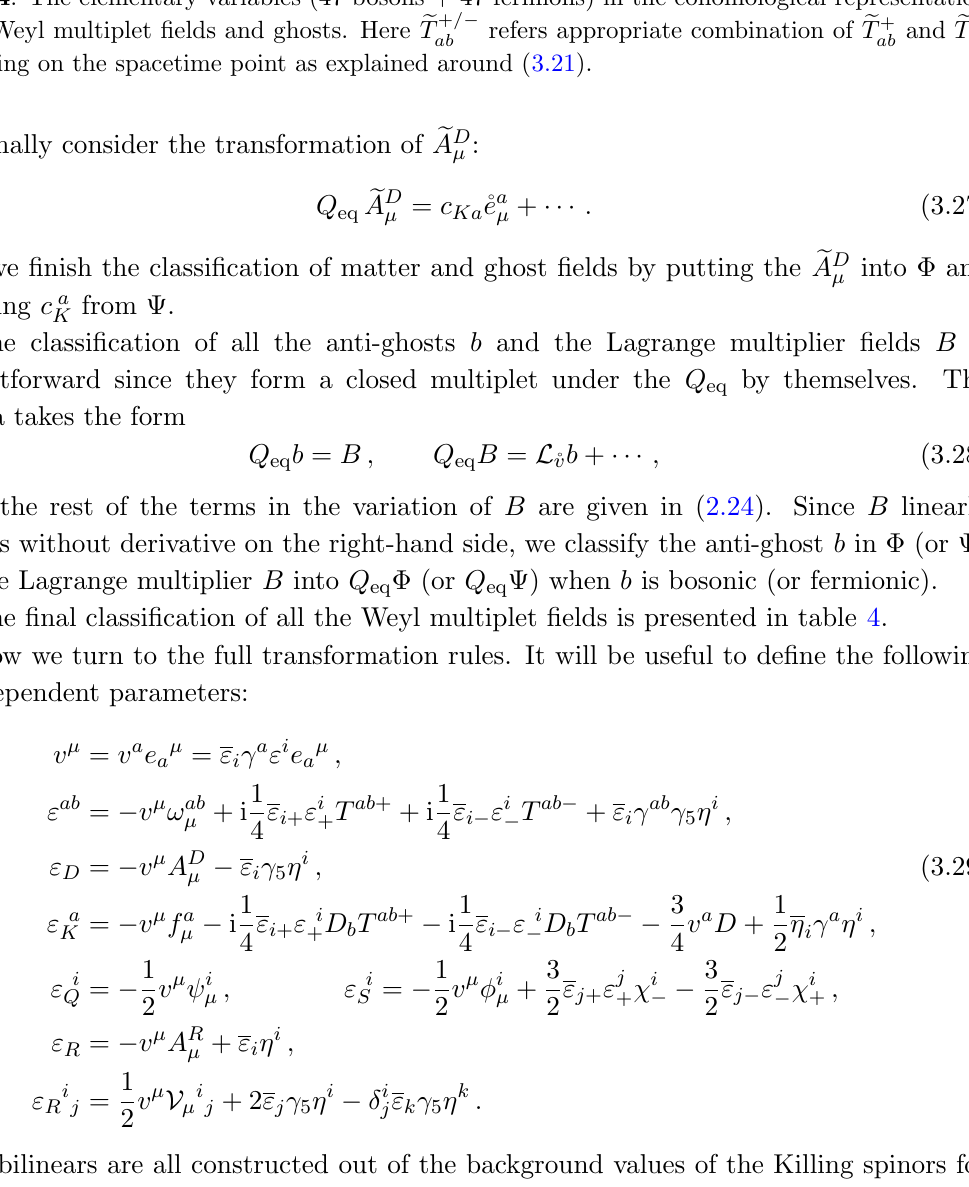
and e T (cid:0) ab ab